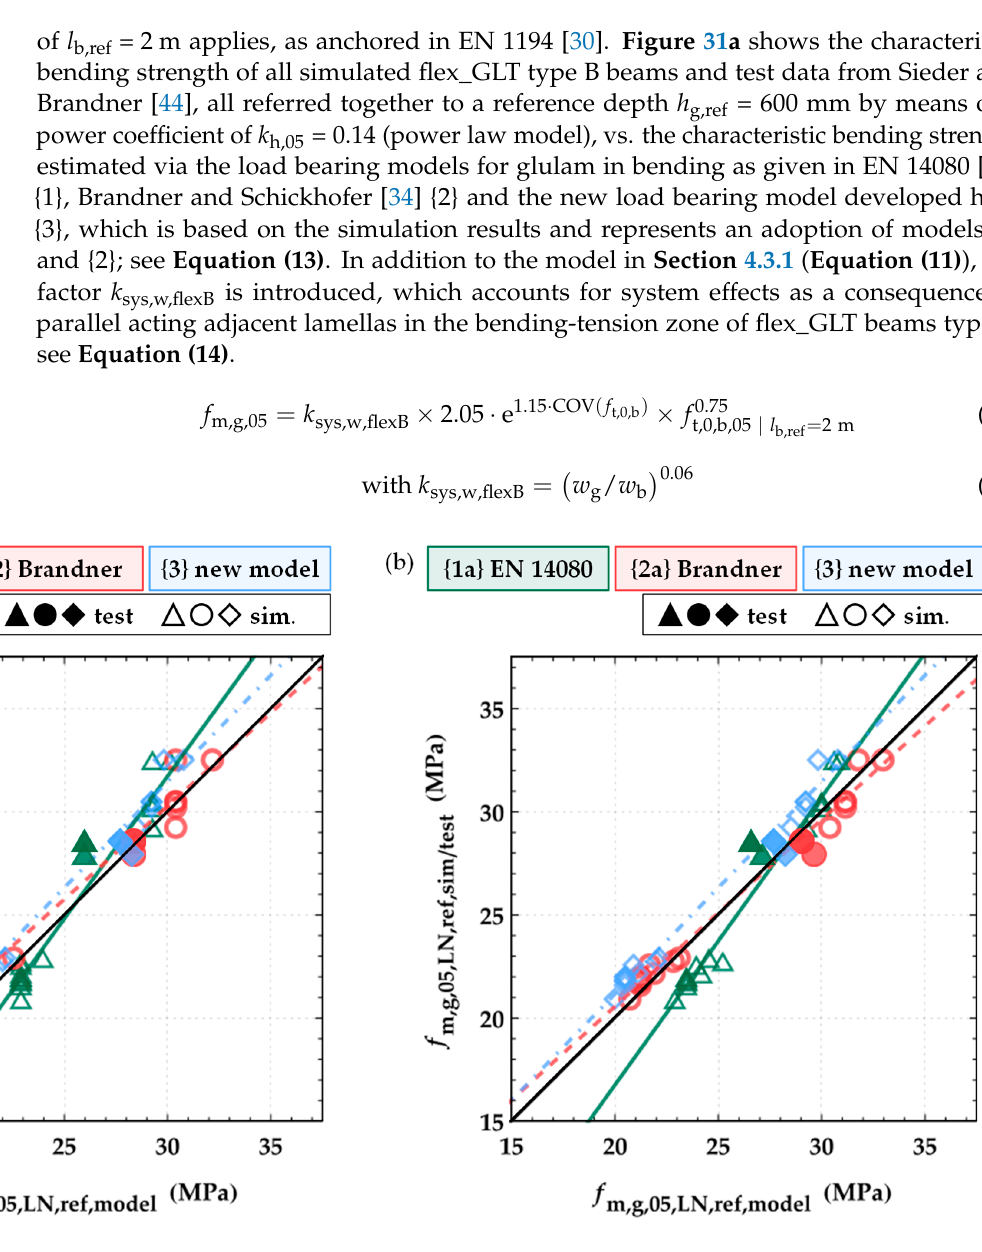
Figure 31. Characteristic (5%-quantile) bending strength values calculated from simulated and tested flex_GLT type B beams taken from Sieder and Brandner [44] ( h g,ref = 600 mm) vs. the characteristic bending strength values according to ( a ) the load bearing model in EN 14080 [10] {1}, Brandner and Schickhofer [34] {2} and Equation (13) {3} based on the characteristic tensile strength parallel to the grain of boards with l b,ref = 2 m and the characteristic bending strength of the finger joints; ( b ) the load bearing models EN 14080 [10] {1a}, Brandner and Schickhofer [34] {2a} and Equation (13) {3}, based on the characteristic (5%-quantile) tensile strength parallel to the grain of boards with l b,ref = 2 m and the characteristic (5%-quantile) bending strength of the finger joints, multiplied by k sys,w,flexB ; see Equation (14) .